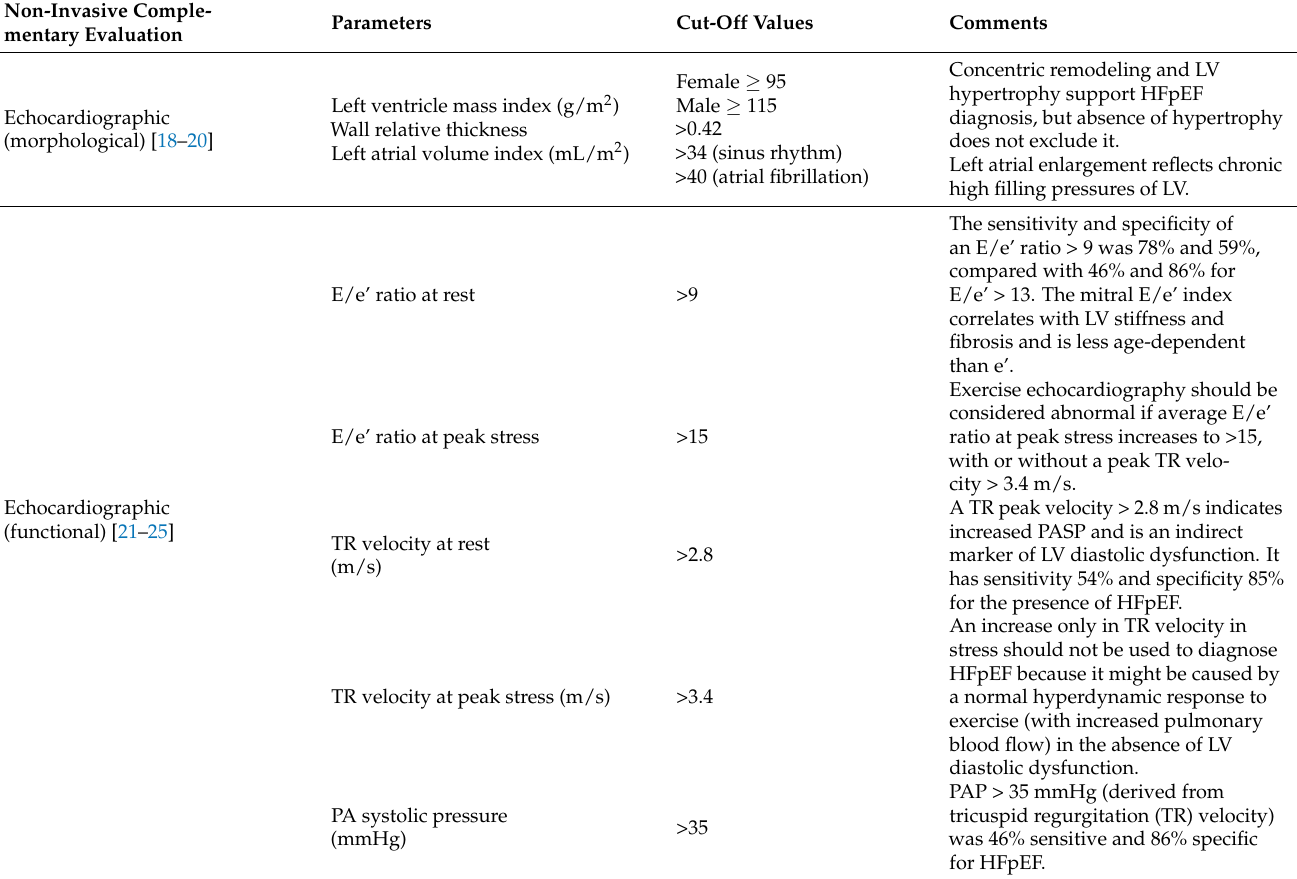
Table 1. Main Echocardiographic features in patients with